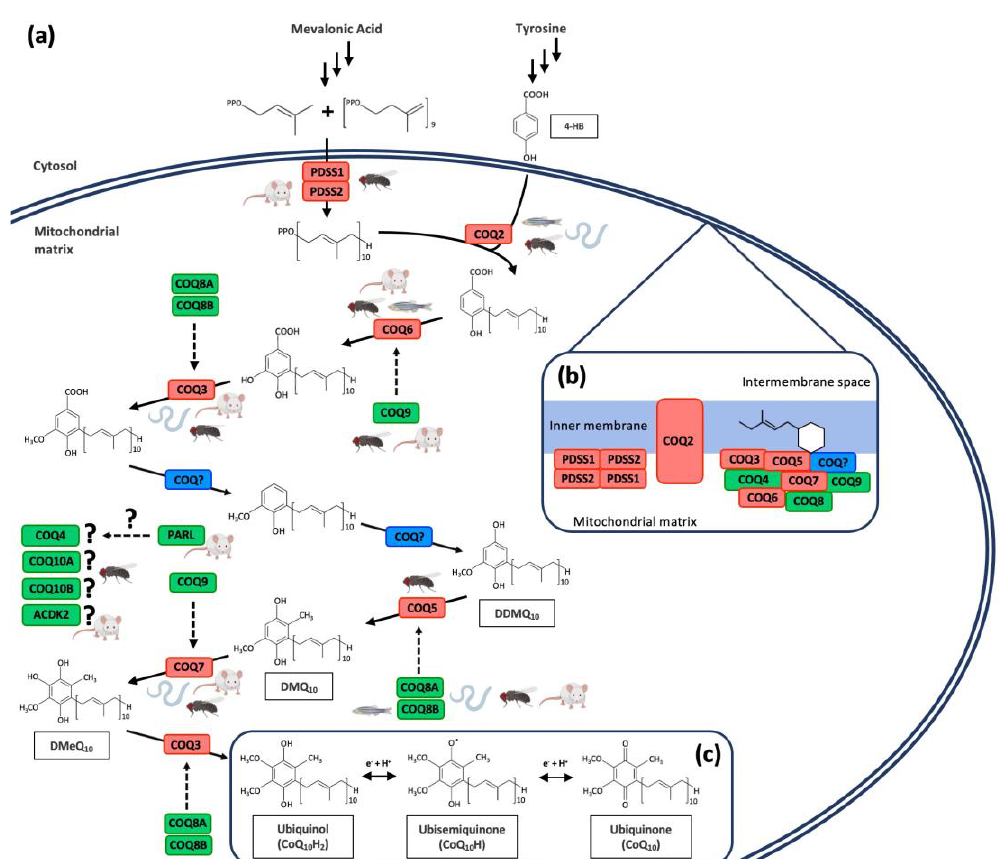
Figure 2. Coenzyme Q 10 biosynthetic pathway and CoQ 10 redox cycle. ( a ) Schematic model of human CoQ 10 biosynthetic pathway. The red color indicates proteins with enzymatic activity. The green color indicates proteins with regulatory function. The blue color shows currently unidentified enzymes. Figures of mouse, C. elegans , D. melanogaster , and zebrafish illustrate animal models with mutation in each specific protein. ( b ) Model of human CoQ 10 biosynthetic complex, containing at least COQ3 – COQ9 and lipids, such as CoQ itself. ( c ) Chemical structure of coenzyme Q 10 and its redox cycle. 4-HB = 4-hydroxybenzoic Acid; DDMQ = demethoxy-demethyl-ubiquinone; DMQ = demethoxyubiquinone; DMeQ = demethylubiquinone.